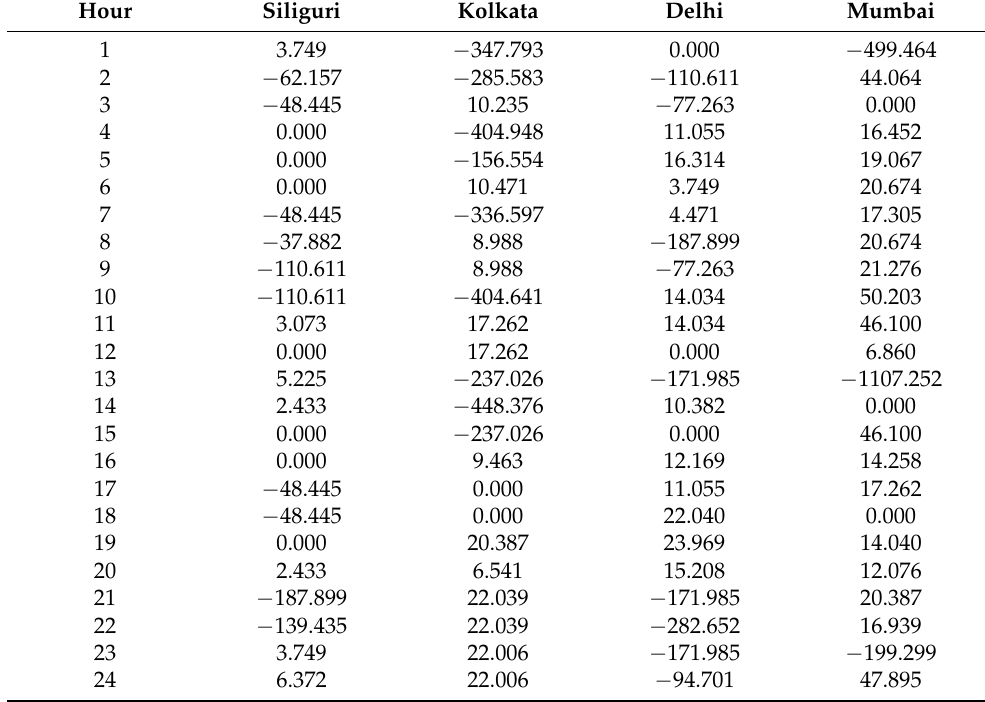
Table 7. Imbalance cost (in $/h) calculation.